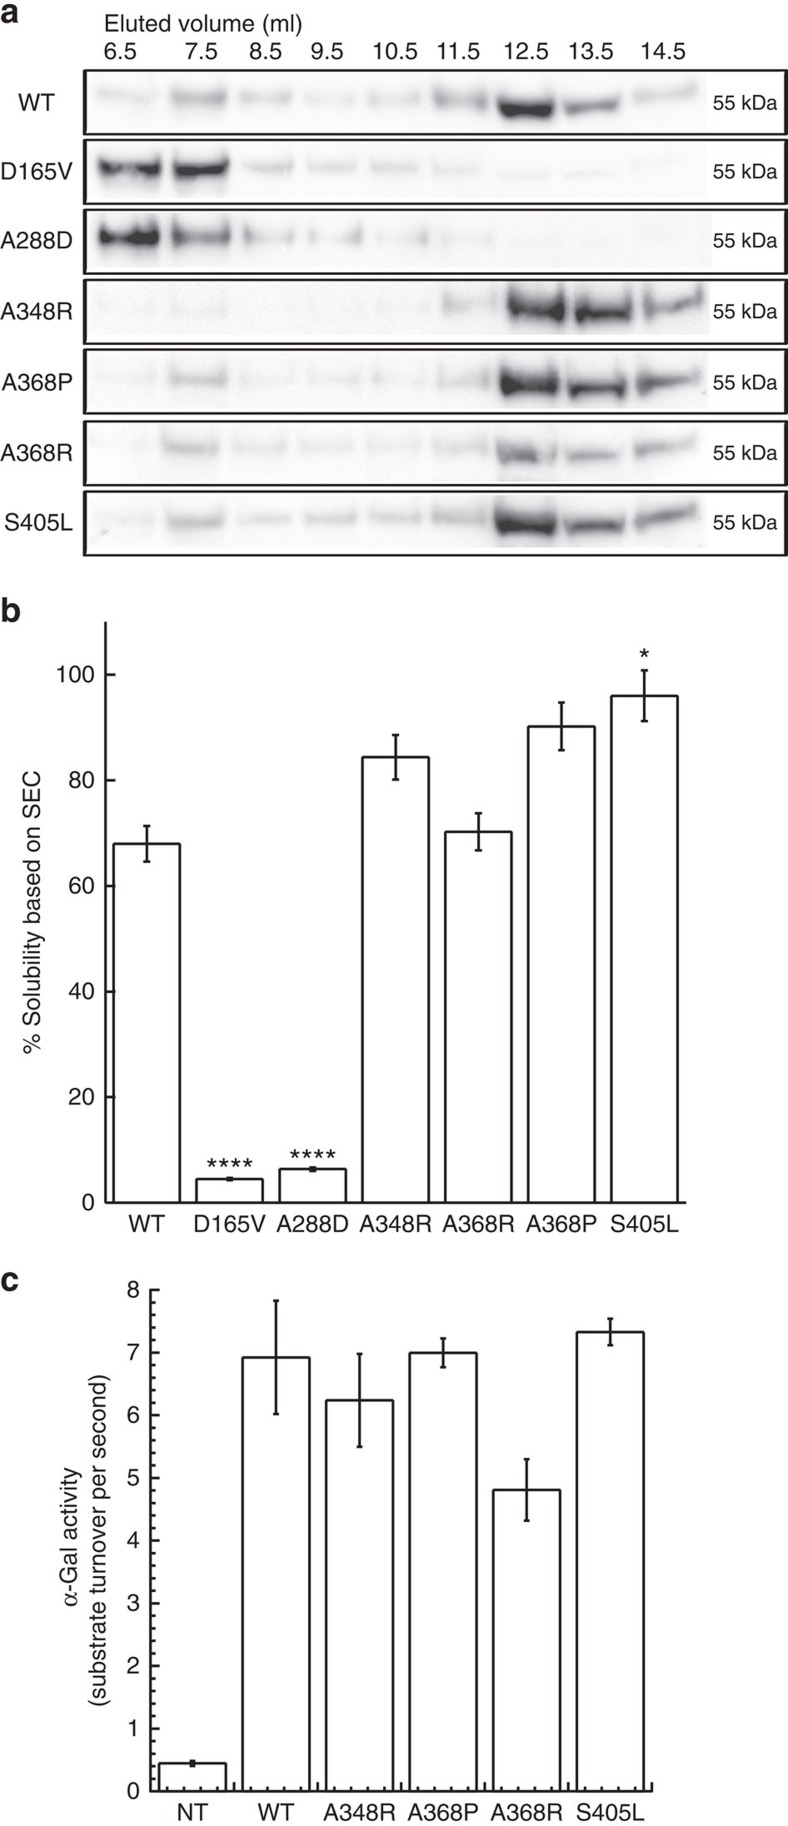
Effect of the single mutations on α-Gal aggregation and activity.(a) Western blot of SEC fractions of WT α-Gal, selected aggregating mutants and single mutants in transiently transfected HeLa cells. WT α-Gal and single mutants eluted in later fractions (12.5–14.5 ml) than the aggregating mutants, corresponding to the active soluble form of the protein. (b) Quantification of the solubility of α-Gal mutants in transiently transfected HeLa cells. The band densities from western blot of SEC fractions from several experiments were quantified. Fractions from 6.5–10.5 ml elution were considered as aggregated, whereas from 12.5–14.5 ml as monomeric. WT α-Gal showed approximately 75% solubility, whereas aggregating mutants were highly insoluble. Single mutants reached ∼80–90% of total solubility (with the exception of the A368R mutant). Statistical significance was calculated as compared with WT α-Gal; ‘*' P<0.05 and ‘****' P<0.0001. (c) Quantification of the enzymatic activity of WT α-Gal and single mutations in transiently transfected HeLa cells. The activity of the WT and the mutants was similar, with a slight reduction in the case of the A368R mutant. Values are mean±s.e.m.